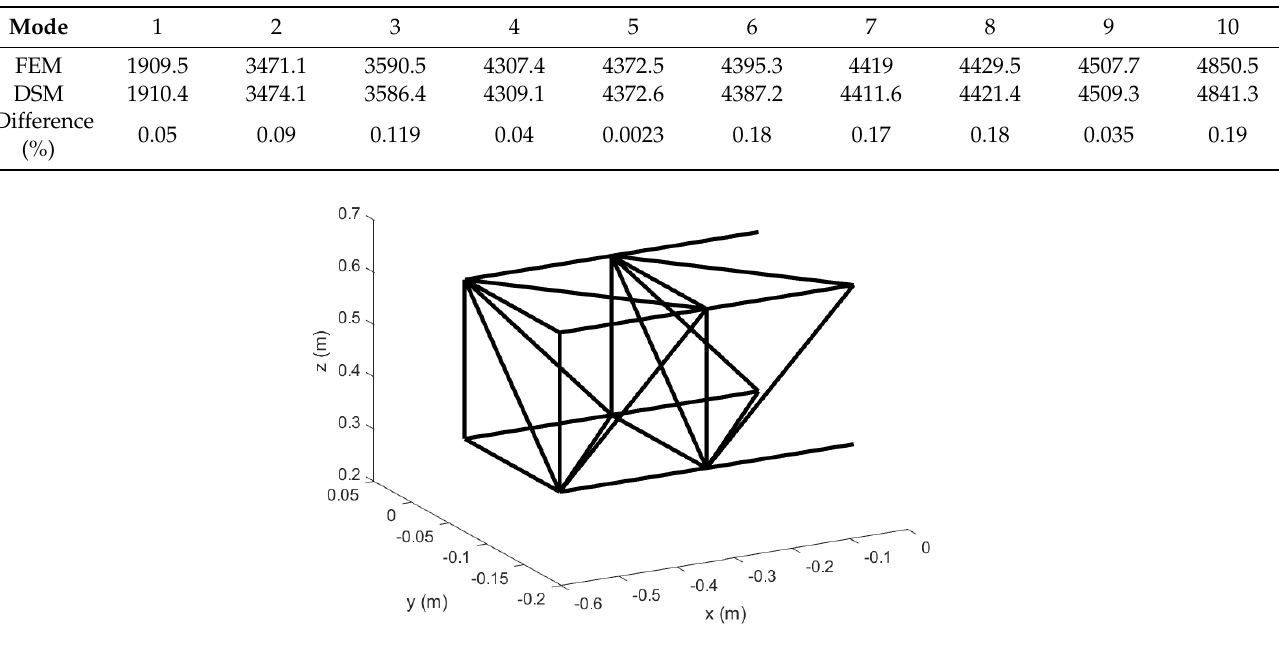
Figure 10. Un–morphed wing in Topology 1 with no hinged ends; original configuration.